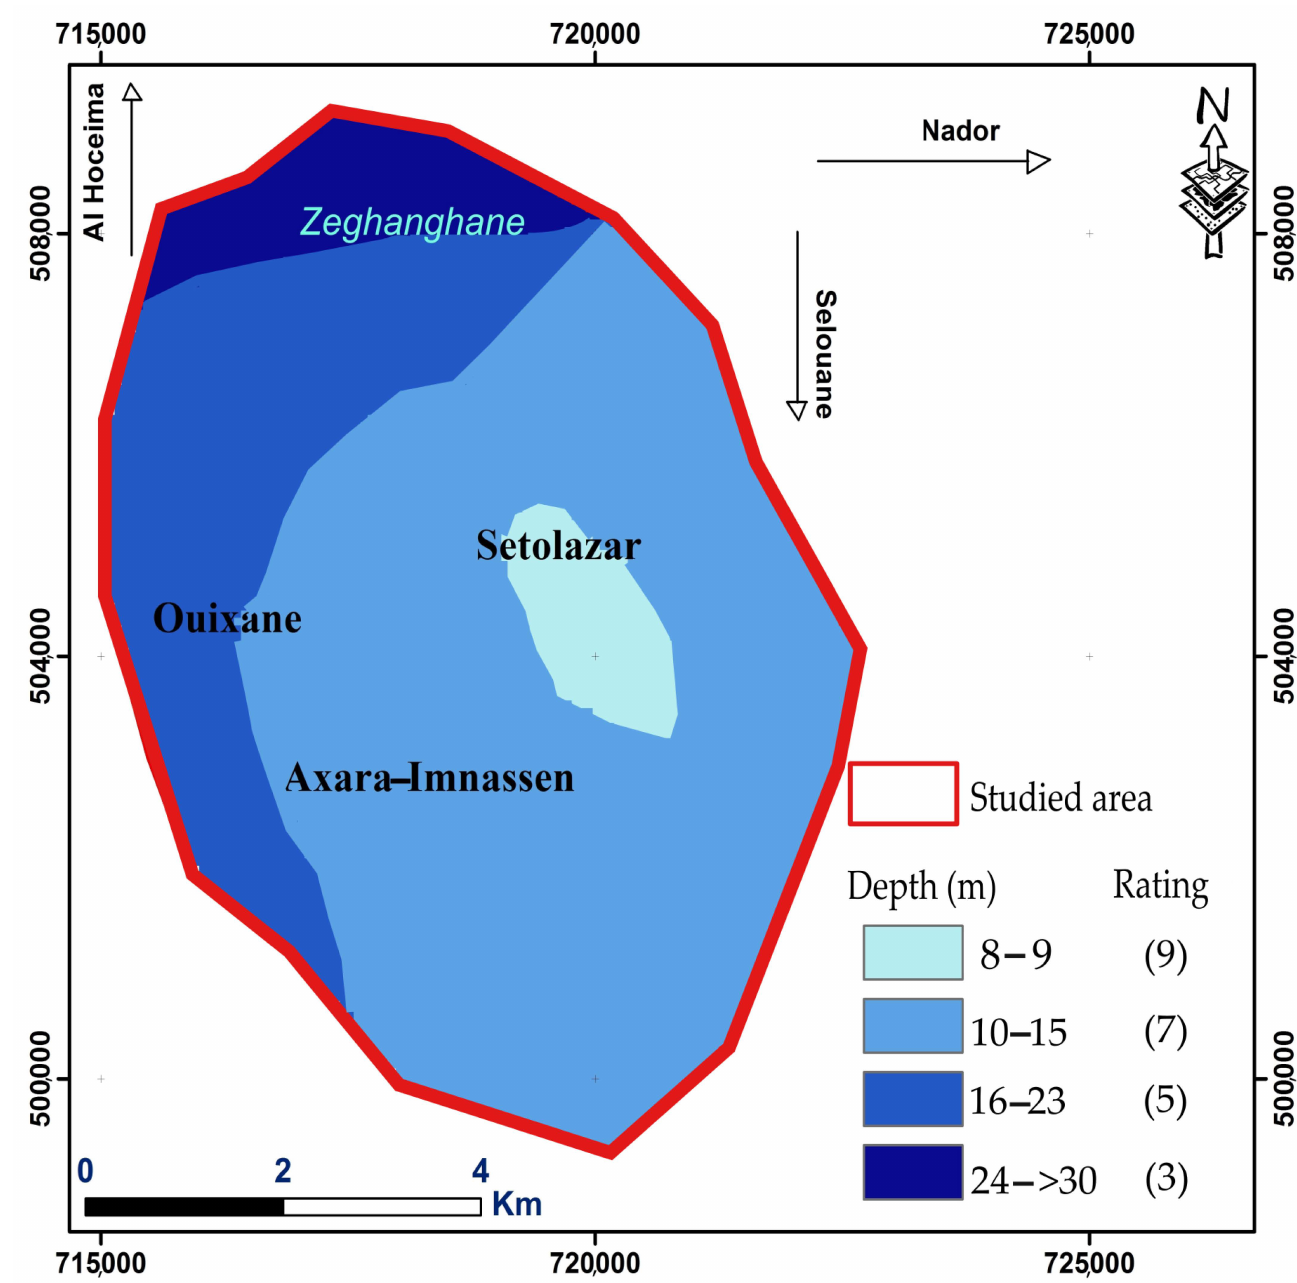
Figure 5. Groundwater depth map and attributed rating